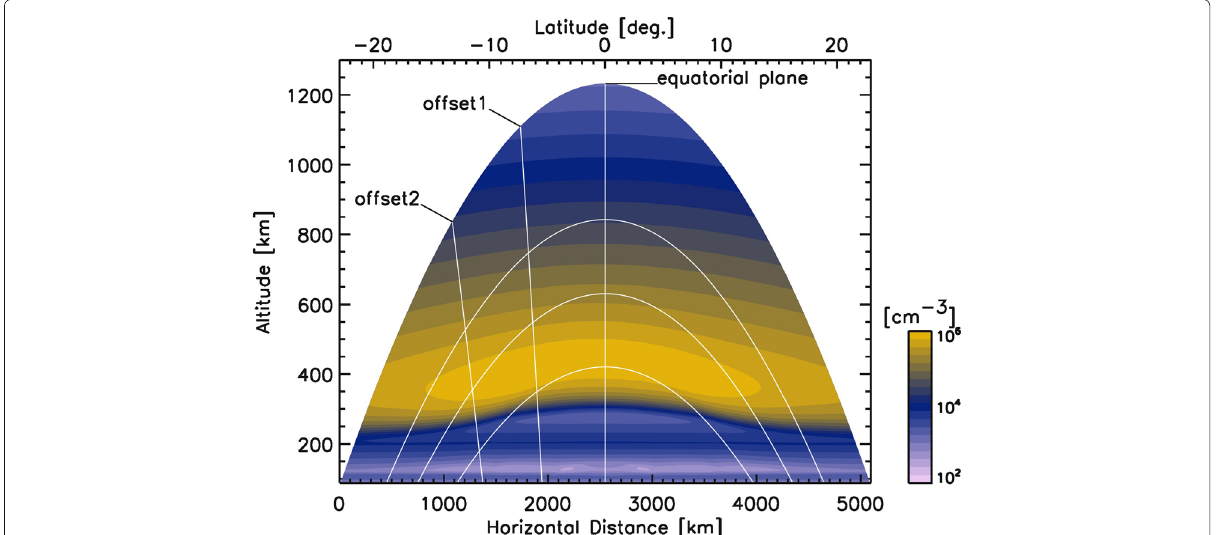
Fig. 2 Meridian slice plane with overlaid rays locating vertical equatorial slice plane and two offset slice planes excised for structure analysis